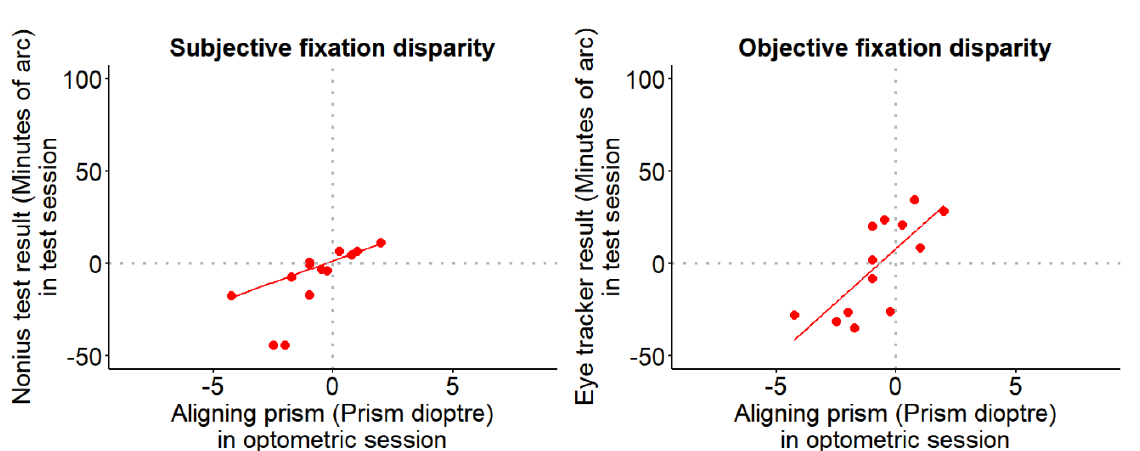
Figure 2: Subjective and objective fixation disparity (measured without wearing aligning prisms) depending on the aligning prism. The fixation disparity has a negative sign for exo, under-convergent states and a positive sign for eso, over-convergent states. The aligning prism has a positive sign for base-out prisms and a negative sign for base-in prisms. All 13 subjects were included in this robust regression